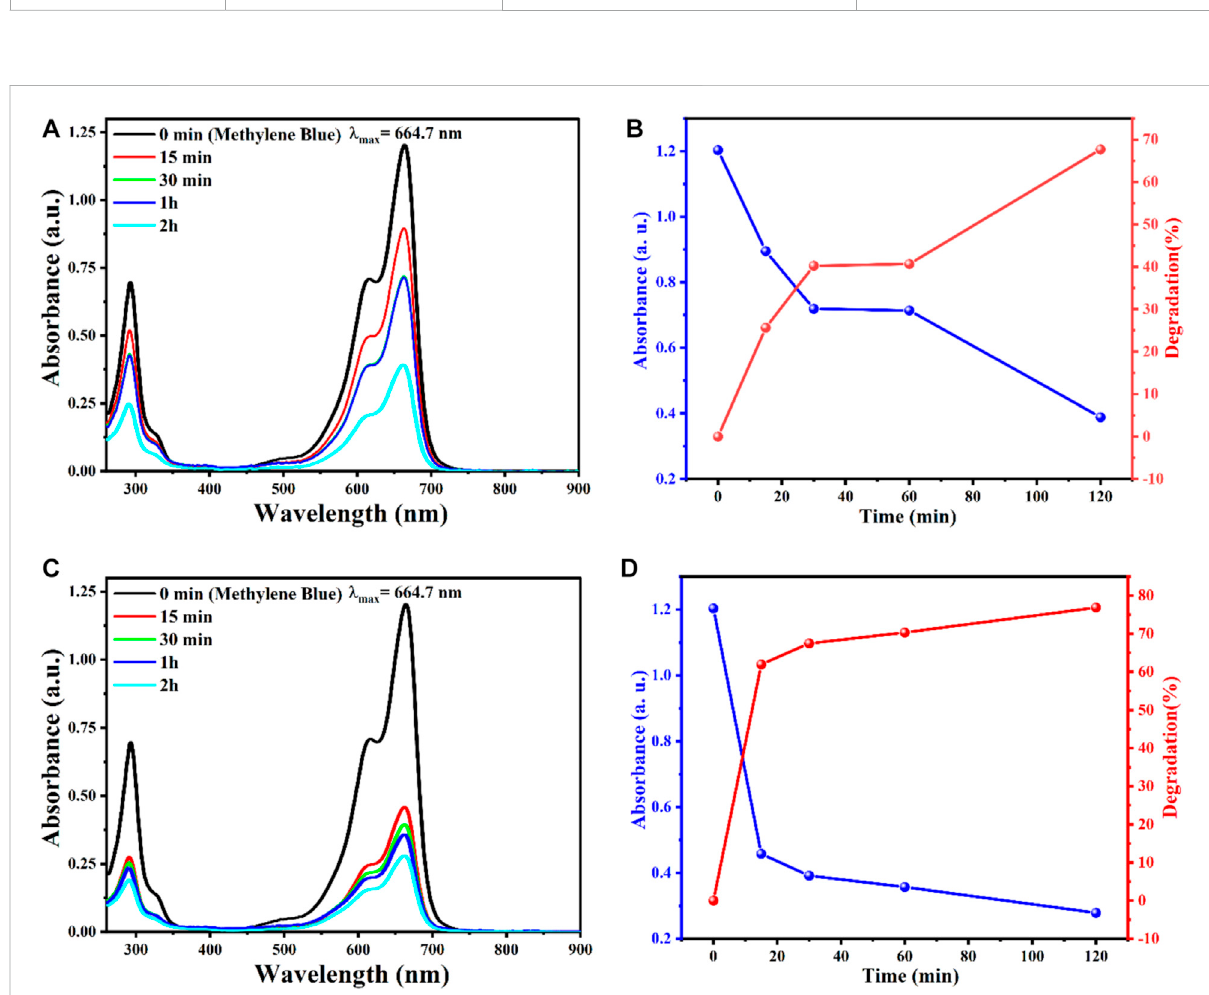
FIGURE 7 The effect reaction time on the degradation of MB, obtained by (A) AgO/Ag 2 O, Absorbance and degradation versus time: (B) AgO/Ag 2 O, (C)